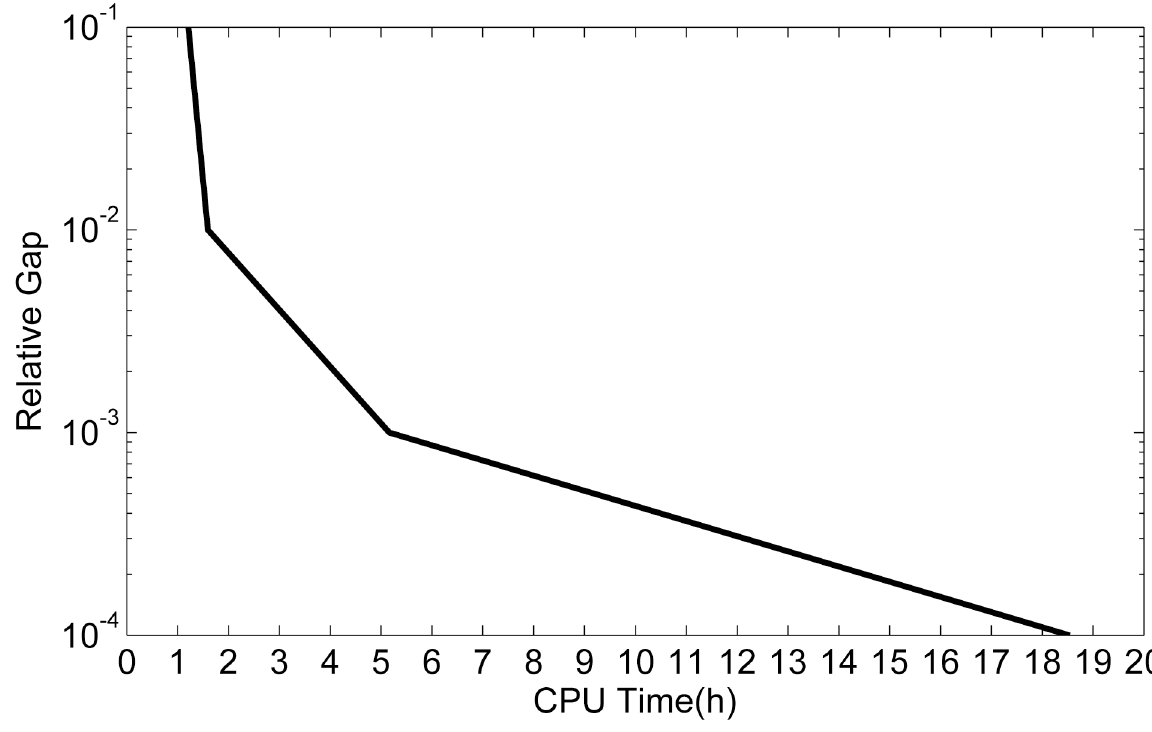
Fig 19. The variation of CPU time with relative